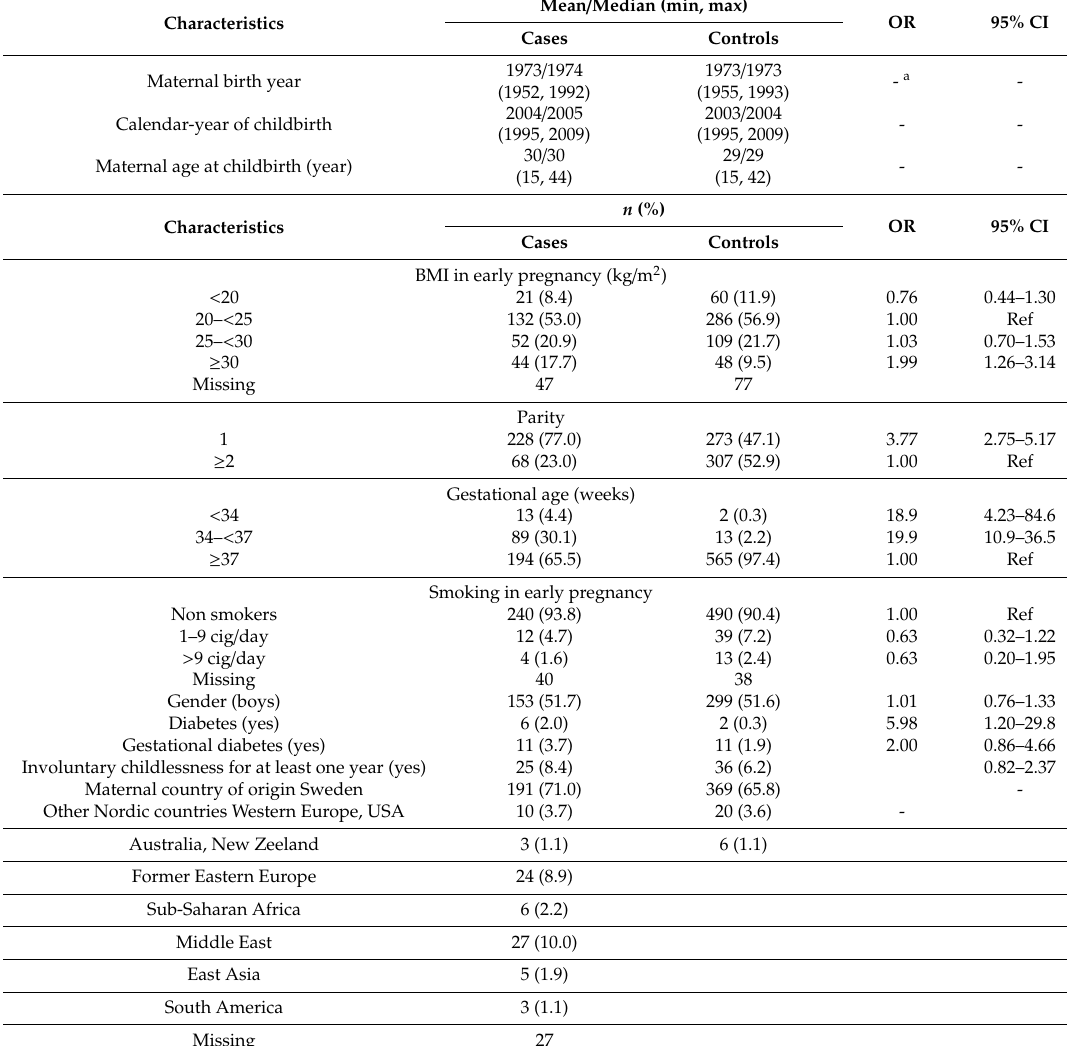
Table 1. Background characteristics among 296 preeclampsia cases and 580 controls. Odds ratios (OR) and 95% confidence intervals (CI) were obtained from univariate logistic regression